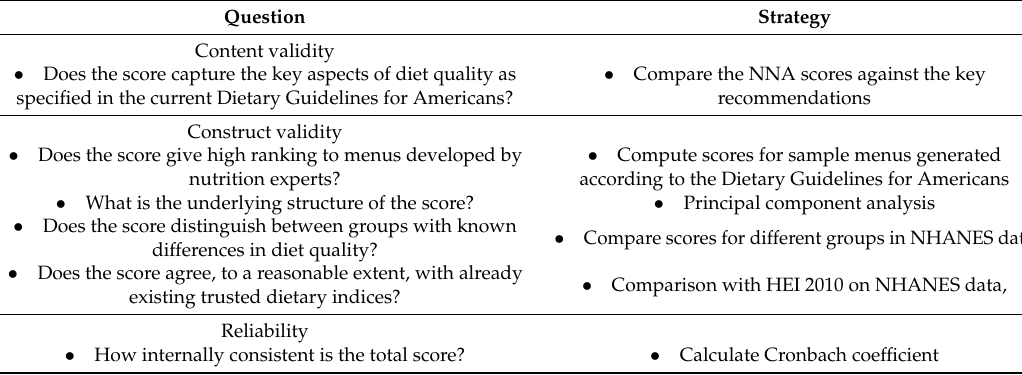
Table 1. Strategies used to validate the new Nestl é Nutrition Algorithm (NNA) (NHANES: National Health and Nutrition Examination Survey, HEI: Healthy eating